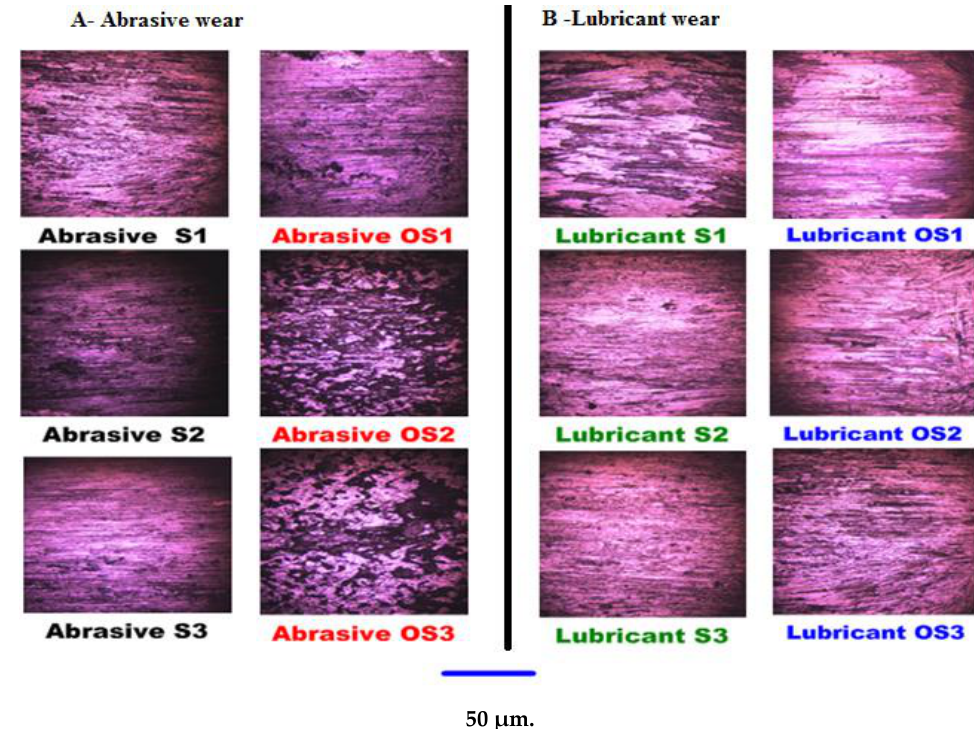
Figure 8. ( A ) abrasive wear, ( B ) lubricant wear. The optical micrograph images of the worn surfaces in the sliding direction of friction for the investigated samples against abrasive and lubricant wear conditions.